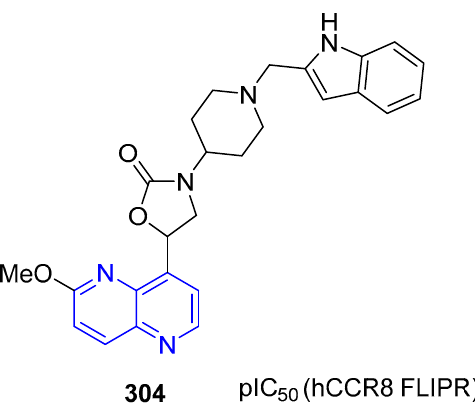
Figure 26. A human CCR8 antagonist. pIC 50 value measure by a fluorometric imaging plate reader assay (FLIPR).